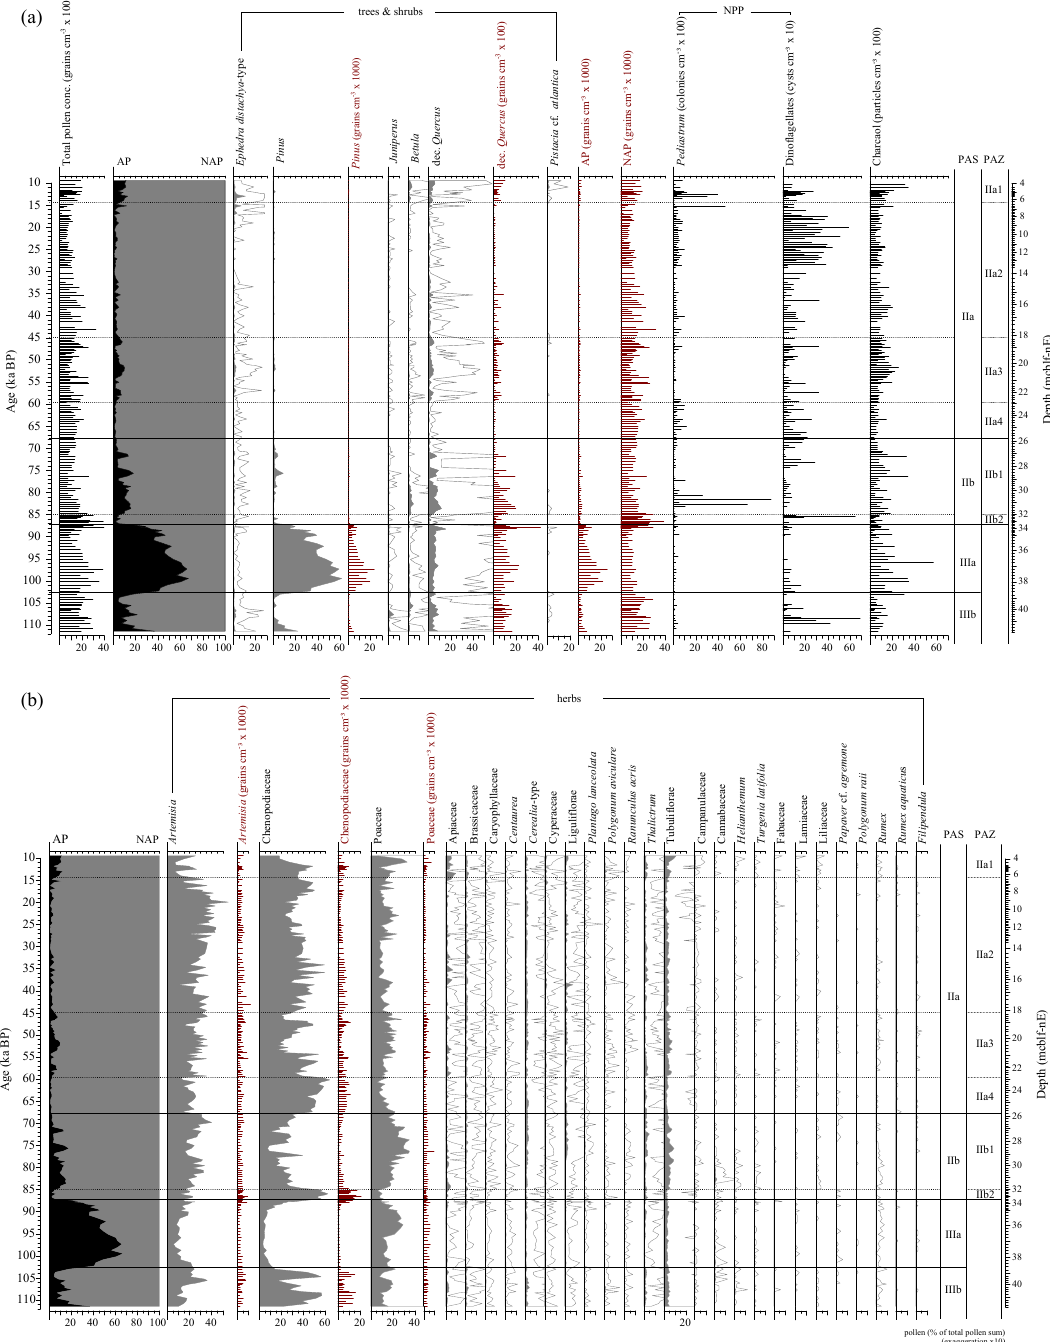
Figure 2. Pollen diagram for the analyzed last glacial period from the Ahlat Ridge composite profile plotted against age (ka BP) and depth (event-corrected composite record; mcblf-nE). A 10-fold exaggeration line (gray) is used to show changes in low percentages. PAS – Pollen assemblage superzone; PAZ – Pollen assemblage zone. For the discussion see Sect. 5. (a) Shown is an arboreal/non-arboreal ratio (AP / NAP), selected arboreal pollen percentages (AP; gray), selected arboreal pollen concentrations (grains cm − 3 ; red bars), non-pollen palynomorph concentrations (NPP) such as Pediastrum , consisting of Pediastrum boryanum spp., P. simplex , and P. kawraiskyi (colonies cm − 3 ; black bars), dinoflagellate concentration (cysts cm − 3 ; black bars), and microscopic charcoal concentration ( > 20µm; particles cm − 3 ; black bars). (b) Shown is an arboreal/non-arboreal ratio (AP / NAP), selected non-arboreal pollen percentages (NAP; gray), and selected non-arboreal pollen concentrations (grains cm − 3 ; red bars) of Artemisia , Chenopodiaceae, and Poaceae.